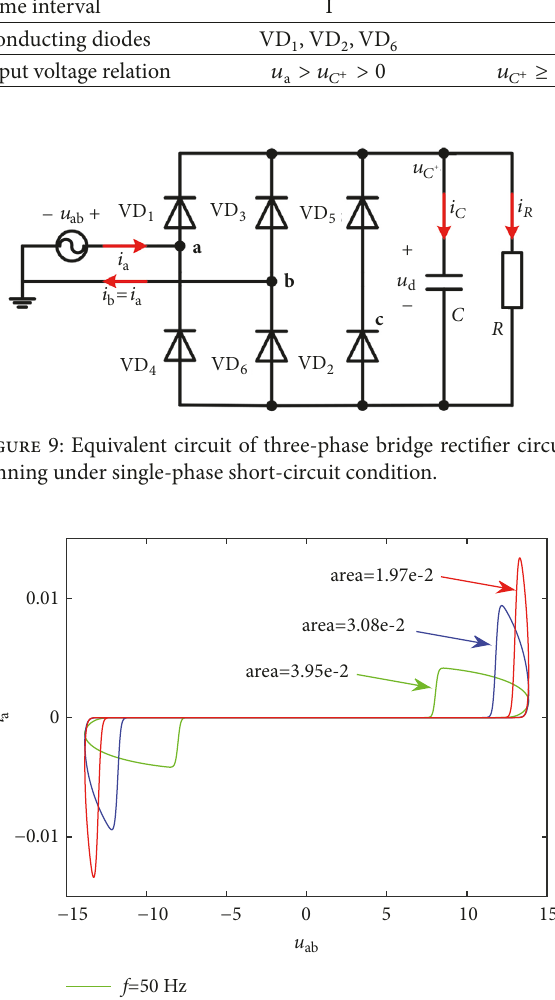
three fingerprints of the generalized memristor. Accordingly,